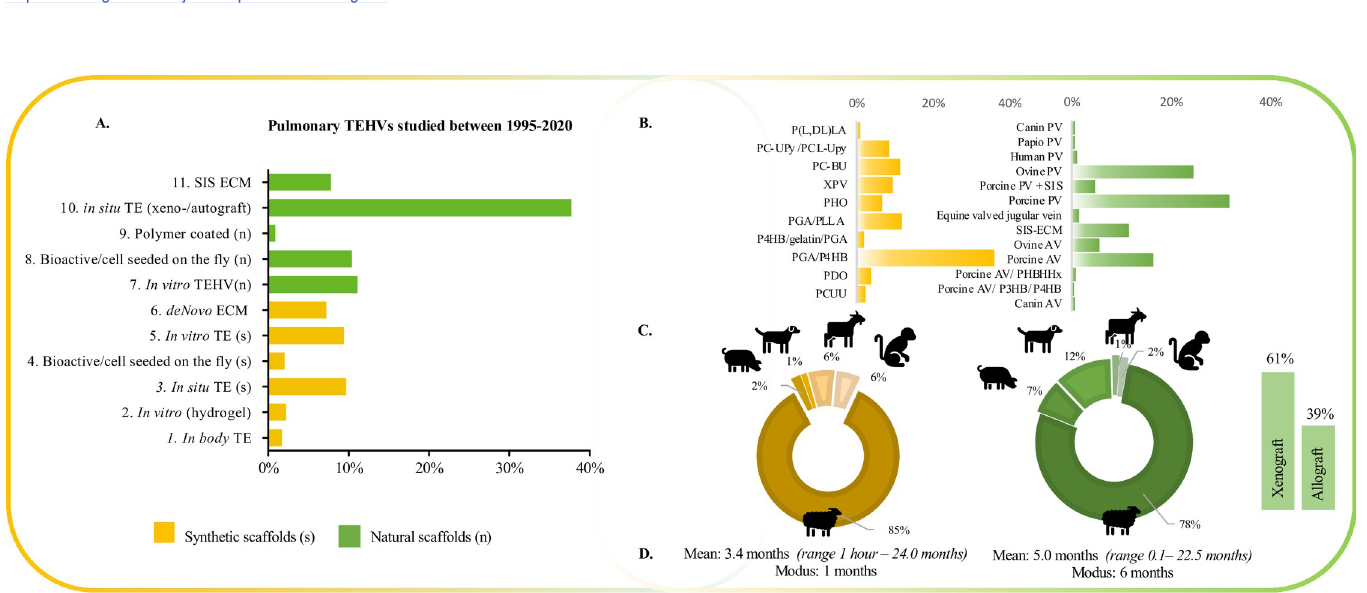
Fig 3. Study characteristics in studies on synthetic- (yellow/orange) and natural (green) based scaffolds. A. Mainly acellular in situ TE was performed with natural scaffold, also mentioned as decellularized xeno-/autografts. Histogram presents percentage of valves of total (n = 693) valve implants. B. Nine different polymers and one not specified (XPV) type were identified in studies analysing polymer- based synthetic scaffolds. Natural valves originated most often from pigs. C. The sheep was the most used animal model in studies on synthetic as well in natural scaffolds. Natural scaffolds were mostly implanted as xenograft D. The most used follow-up time for synthetic scaffolds was shorter (modus 1 month) compared to that of natural scaffolds (modus 6 months). AV : Aorta valve . BU; Bis-urea ECM; Extracellular matrix P(L , DL)LA; Poly (L-lactide-co-D , L-lactide) . P4HB; Poly-4-hydroxybutyrate PC; Poly-carbonate PCL; Polycaprolactone PCUU; Poly-carbonate urethene urea PDO; Poly(1 , 4-dioxan-2-one) PGA; Polyglycolic Acid . PHO; Polyhydroxyoctanoate PV; Pulmonary valve . SIS; Small intestinal submucosa TE; Tissue engineering TEHV; Tissue engineered heart valve . UPy; 2-ureido-4[1H]-pyrimidinone .